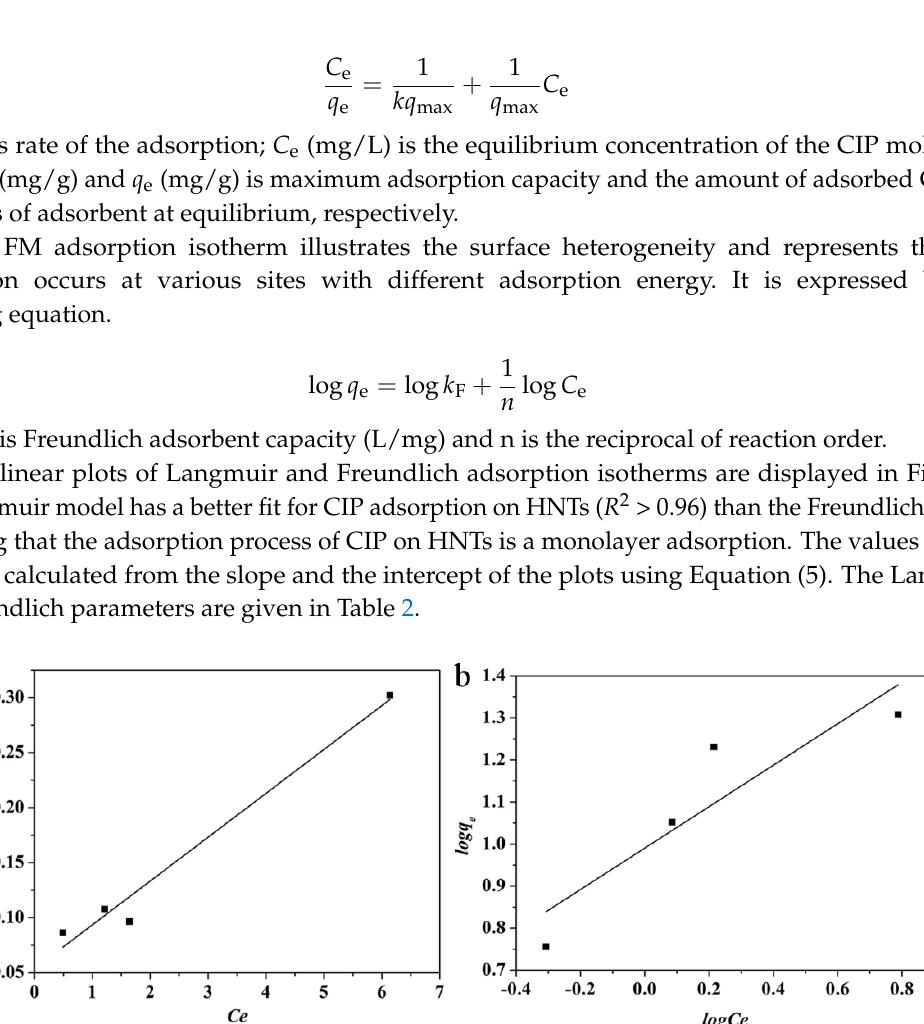
Table 1. Kinetic parameters for the pseudo-first-order and pseudo-second-order models.